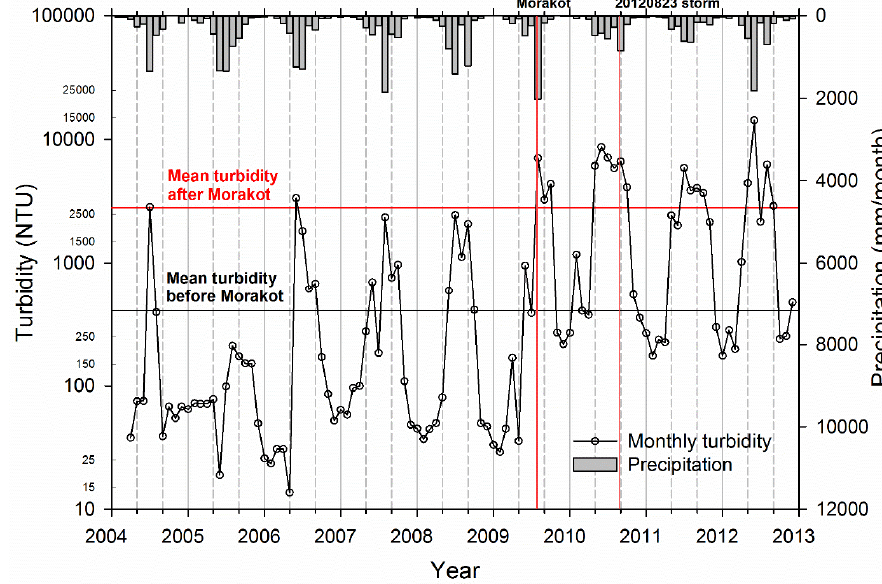
Figure 5. Temporal trends of the observed water turbidity (left y -axis) in GRD and the monthly averaged precipitation (right y -axis) in GRB during March 2004 to December 2012.